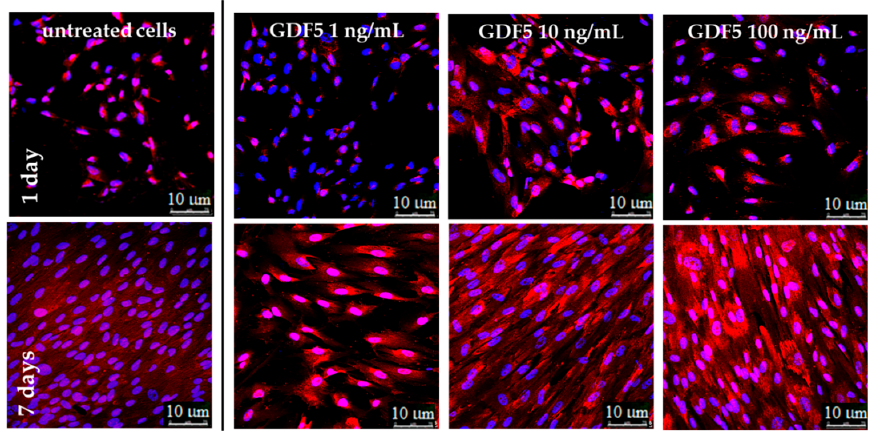
Figure 6. IF images illustrating the type 1 collagen expression at different hGDF-5 dose on hWJ-MSCs. Protein was stained in red and monitored up to seven days of culture.